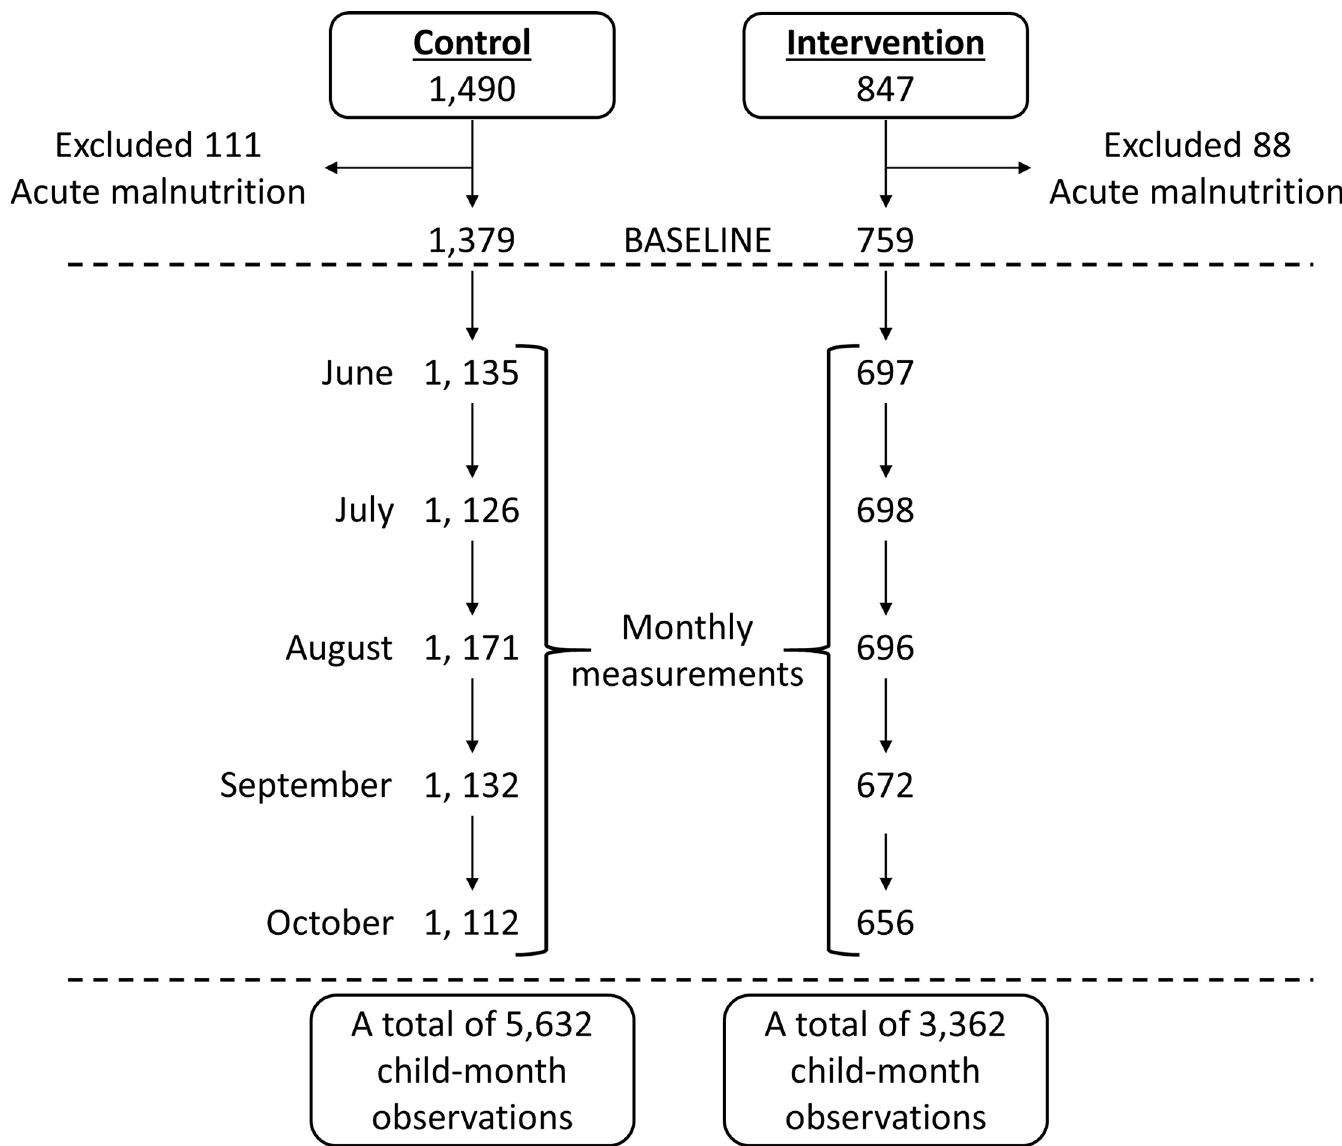
Fig 2. Child cohort participant flow